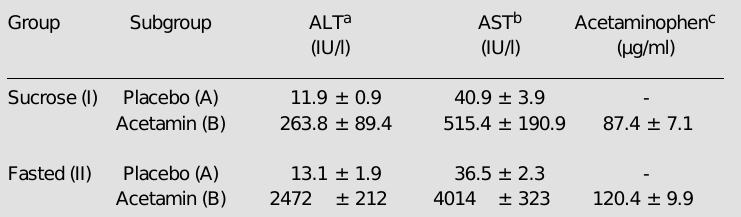
Figure 1 - Gastric retention (%) after the orogastric administra- tion of a saline test meal in su- crose-fed (I) or fasted (II) animals given either a placebo (A) or a- cetaminophen (B). Gastric reten- tion was assessed 10 min after the test meal. The results are shown as box plots (see Statisti- cal analysis for further